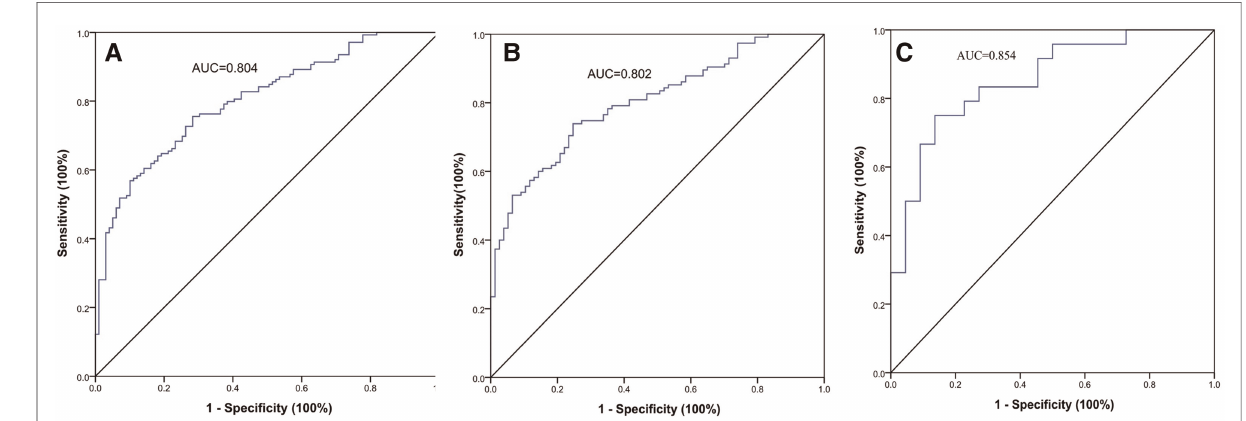
FIGURE 4 The ROC curves of the visceral adipose tissue index (VATI) for early recurrence (ER) of HBV-related HCC after hepatectomy. The AUC value was 0.804 in two cohort ( A ), 0.802 in internal training cohort ( B ), and 0.854 in external validation cohort ( C